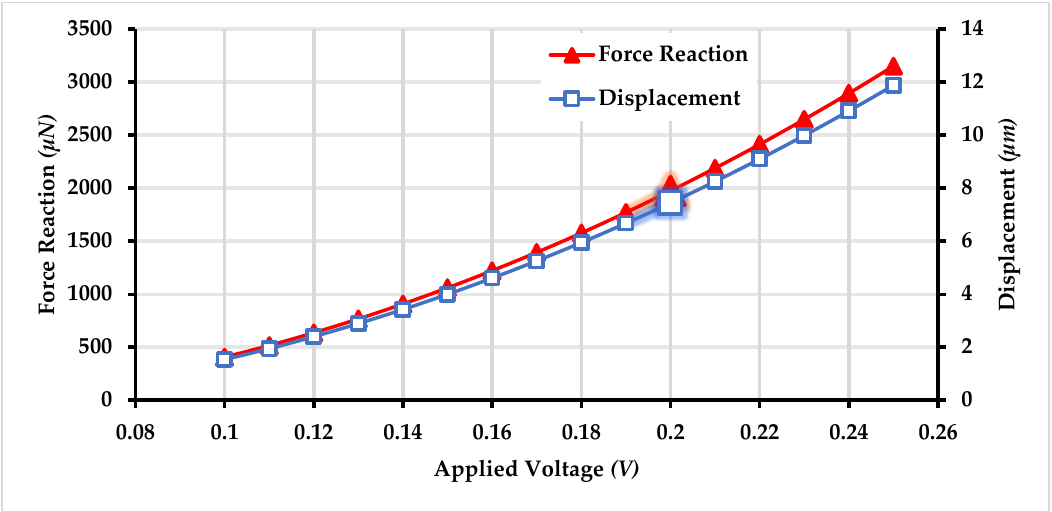
Figure 17. Output force and displacement of the electro-thermal actuator with increasing actuation voltage.